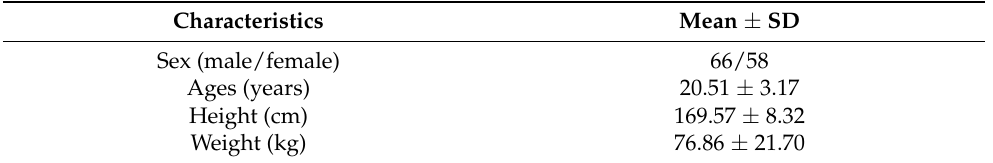
Table 1. General characteristics of participants ( n =